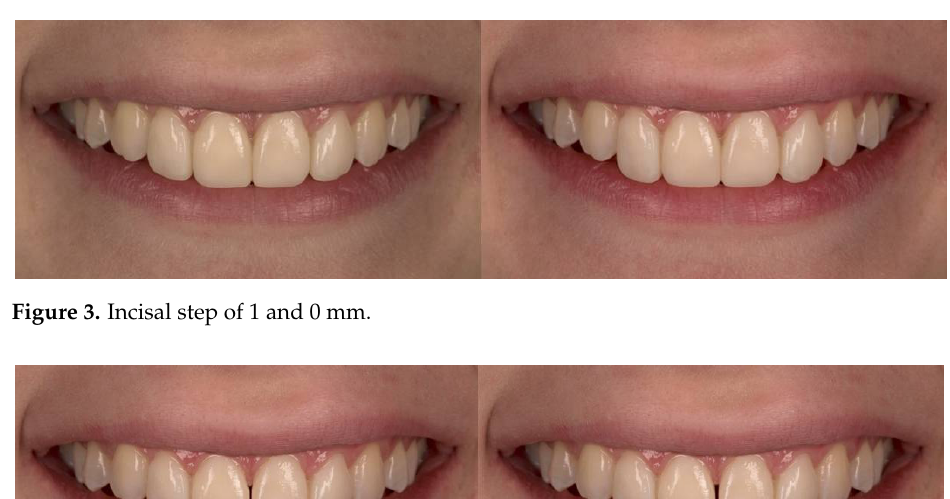
Figure 2. Rounded and squared incisal embrasures .